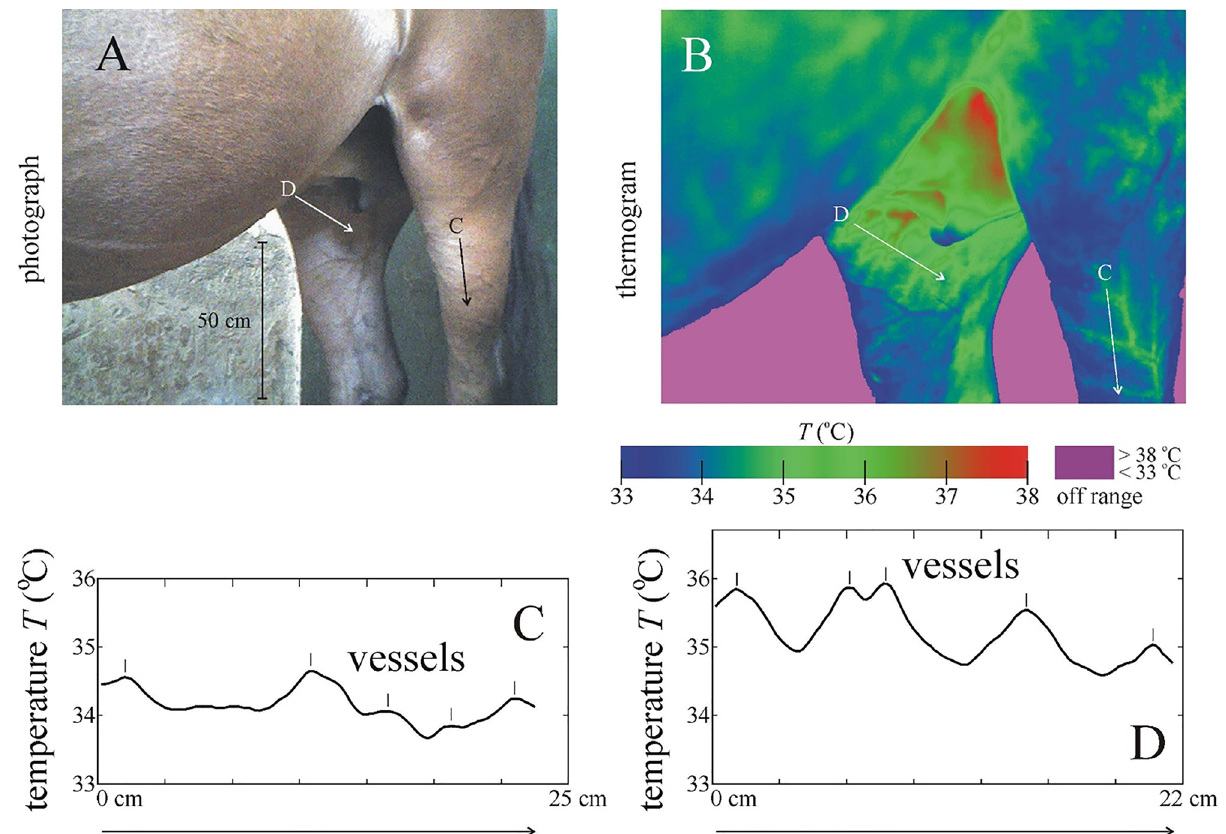
Figure 4. Photograph ( A ) and thermogram ( B ) of a shady brown horse at ambient air temperature of 35 °C. ( C,D ) Surface temperature T ( o C) along arrows ( C,D ) in the photo and thermogram. In panels ( C–E ) the vessels are marked by vertical